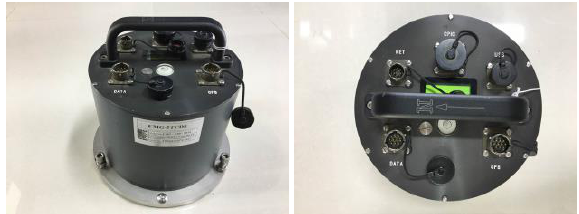
Figure 2. The vibration monitoring apparatus (CMG-5TCDE)